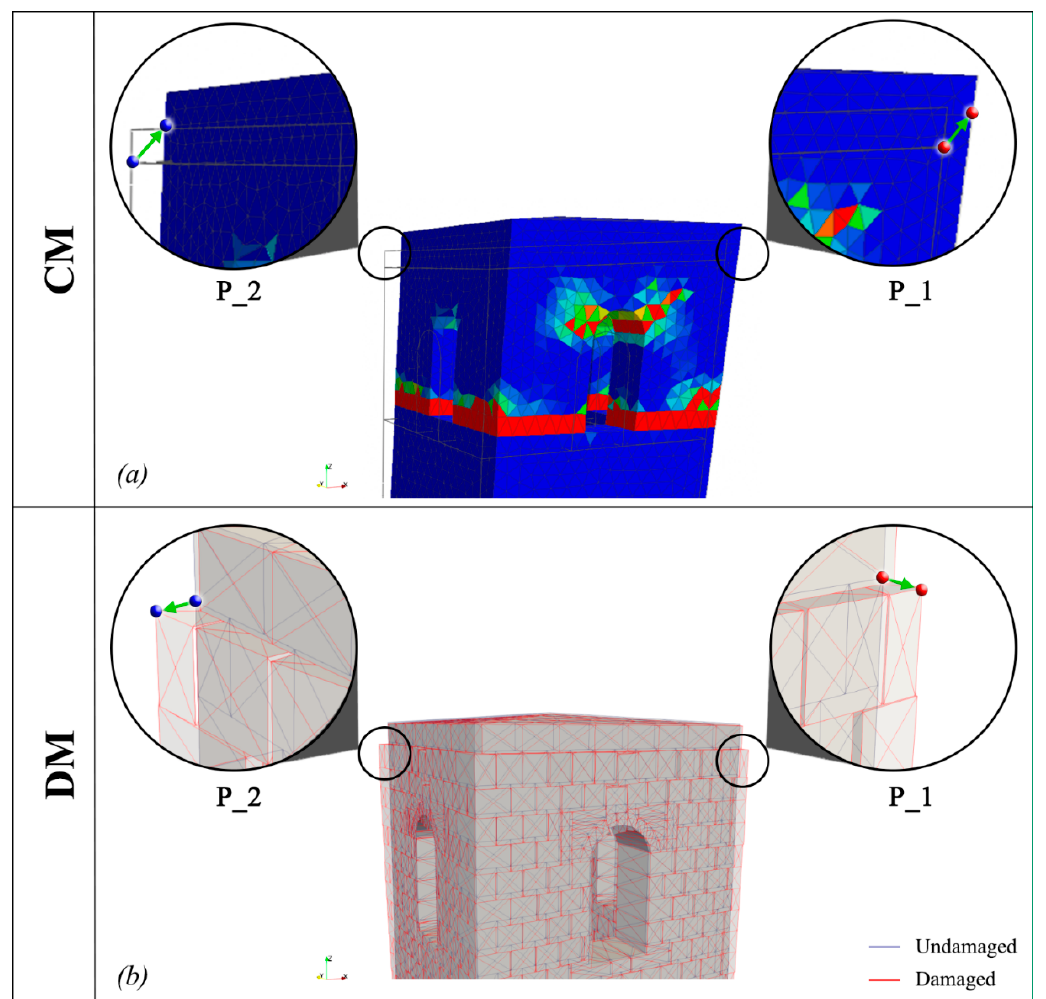
Figure 10. Differences between the undamaged and damaged states of CM ( a ) and DM ( b ) in the bell cell.